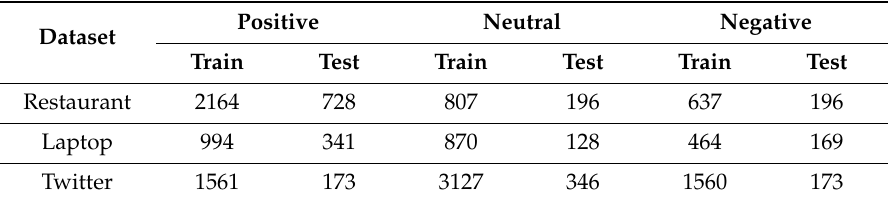
Table 1. Statistics of the